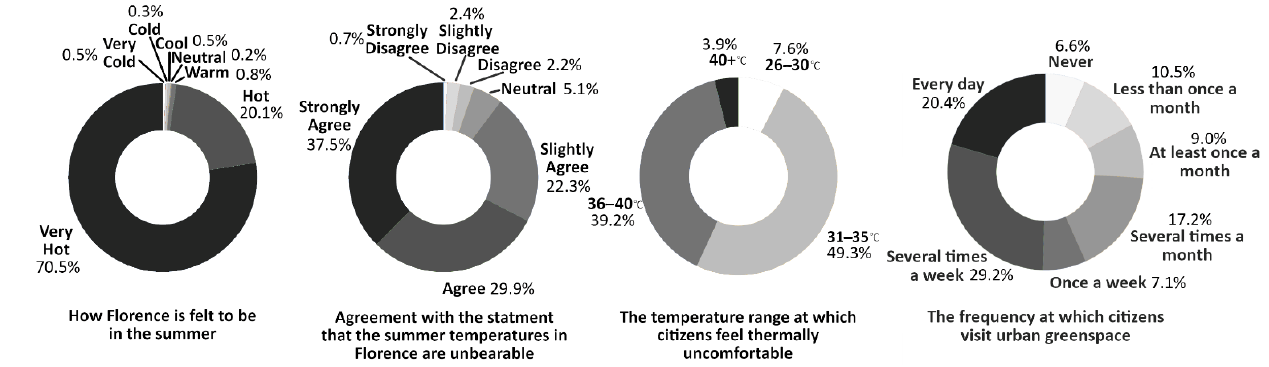
Figure 1. Donut charts representing response proportions to survey questions ( n = 592).